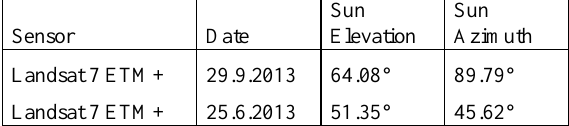
Table 1. Details of Landsat images used in this study.